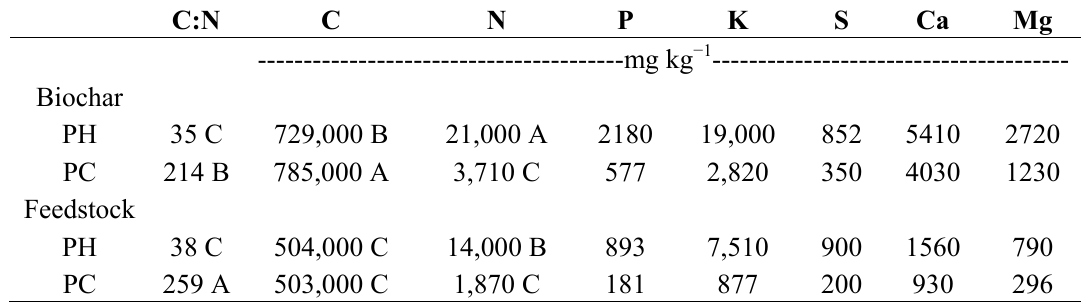
Table 1. Total concentrations of selected major and minor nutrients from peanut hull (PH) and pine chip (PC) biochars and their respective feedstock.